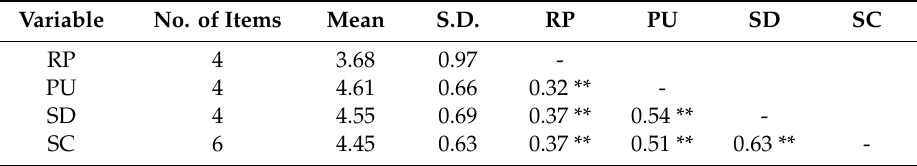
Table 3. Means, standard deviation, and